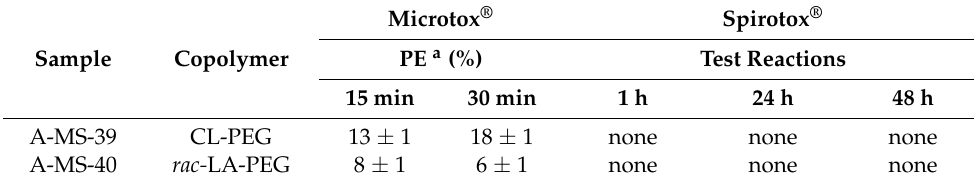
Table 4. Cytotoxicity of the obtained